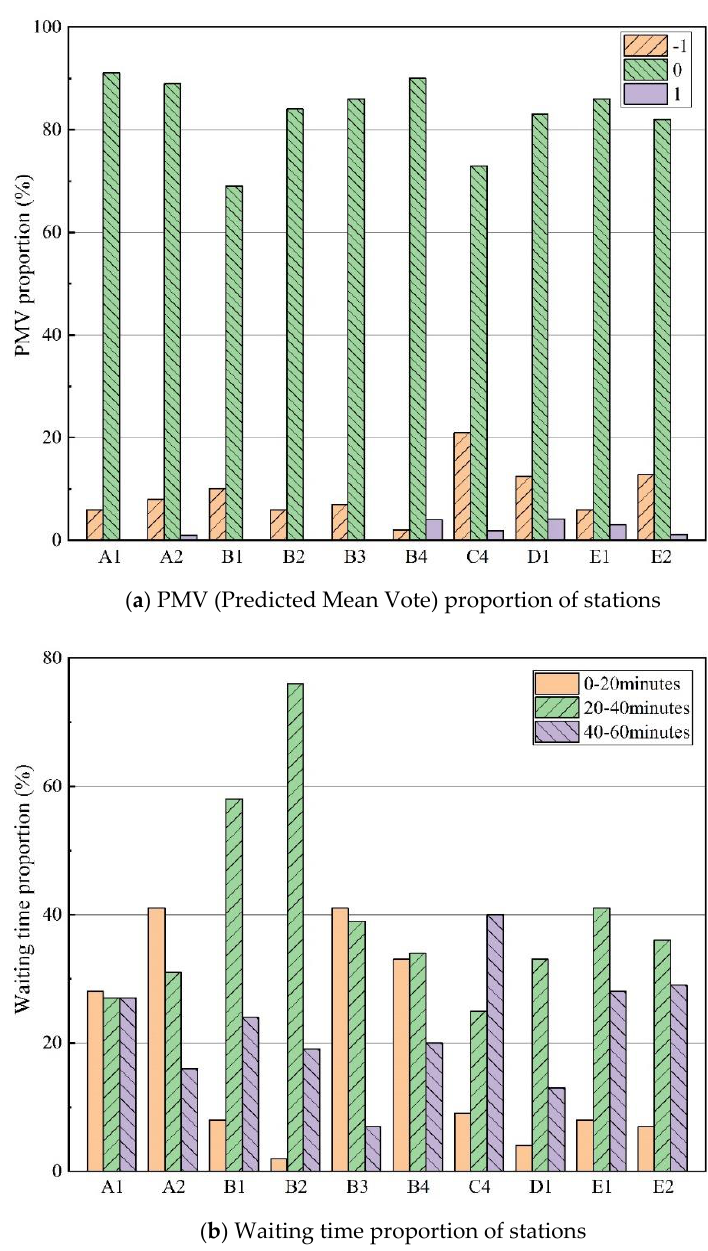
Figure 12. PMV and waiting time proportion of stations.